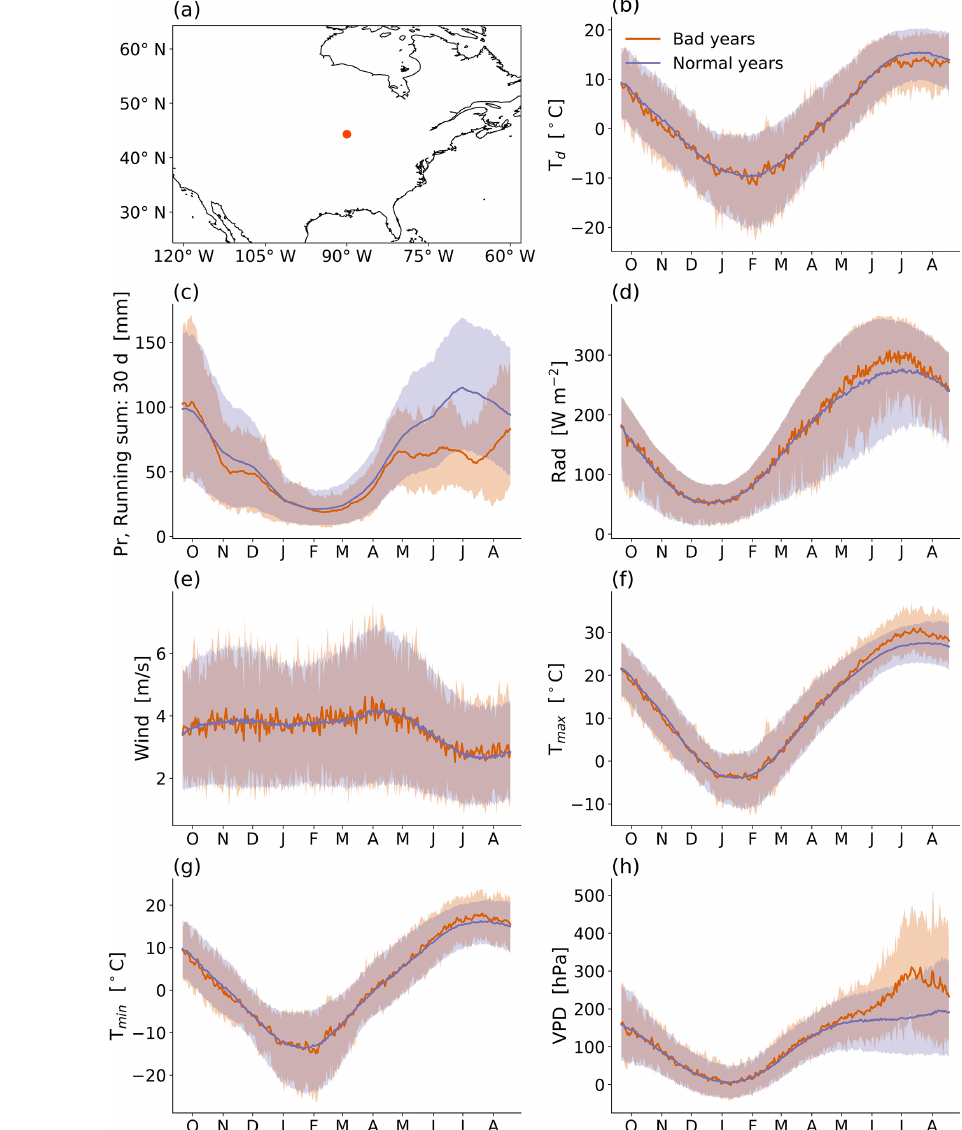
Figure B2. As Fig. 2 but for a grid point in the United States (44.3 ◦ N, 90.0 ◦ W).